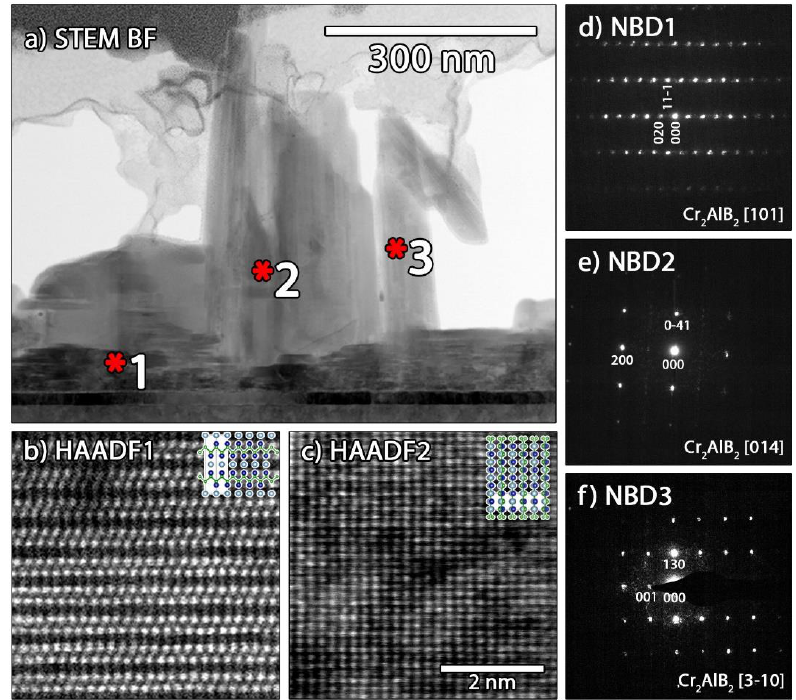
Figure 6. TEM analysis of different growth modes in sample A: ( a ) bright field STEM image with marked positions for structural analysis, ( b , c ) atomic resolution high-angle annular dark field images (HAADF) STEM image of [101] and [014] zone axis orientation recorded at spots 1 and 2, respectively, as marked in ( a ), the same scale bar applies in ( b , c ). ( d , e ) NBD patterns of [101], [014] and [3–10] zone axis orientation recorded at spots 1, 2 and 3, respectively, as marked in ( a ).